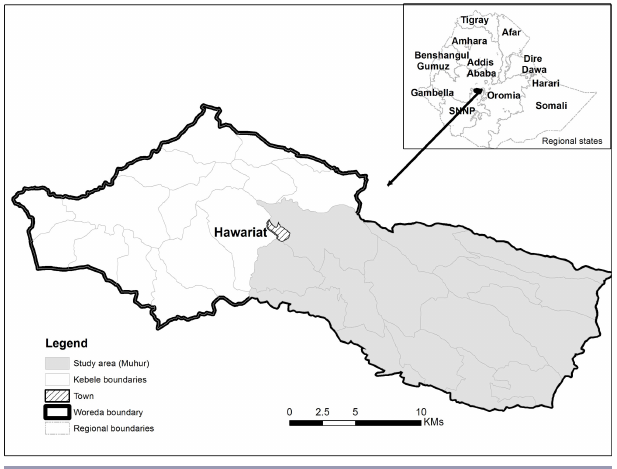
Fig. 1 . Map showing the location of